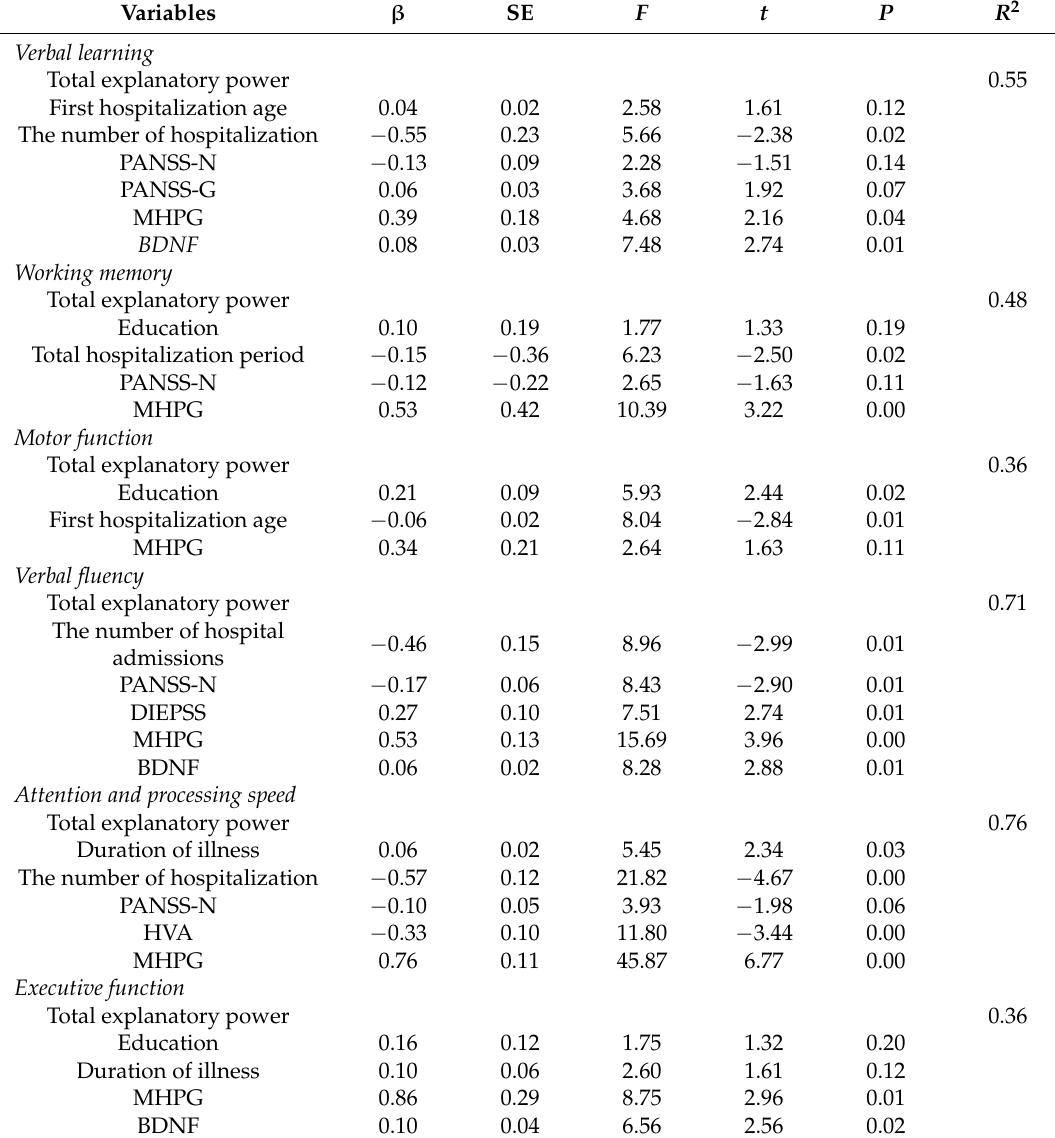
Table 2. Multivariate analysis for the cognitive function treated with